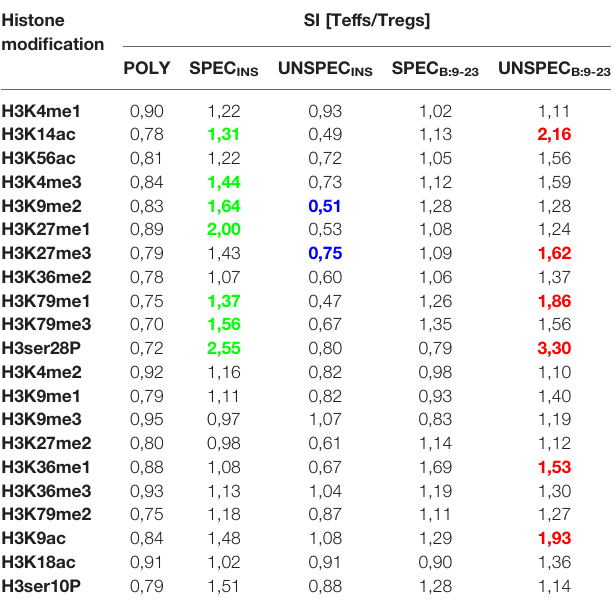
TABLE 4 | Selectivity index (SI) for histone modi fi cations.